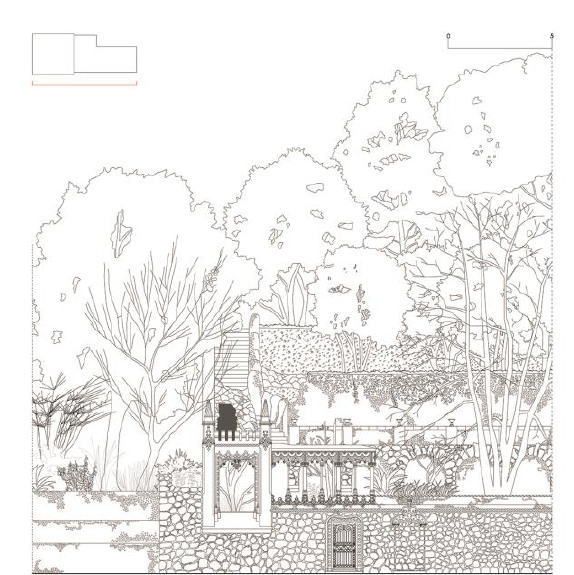
Figure 3 . The Quinta da Regaleira in Sintra , the Loggia dos Pisoes , main prospect.